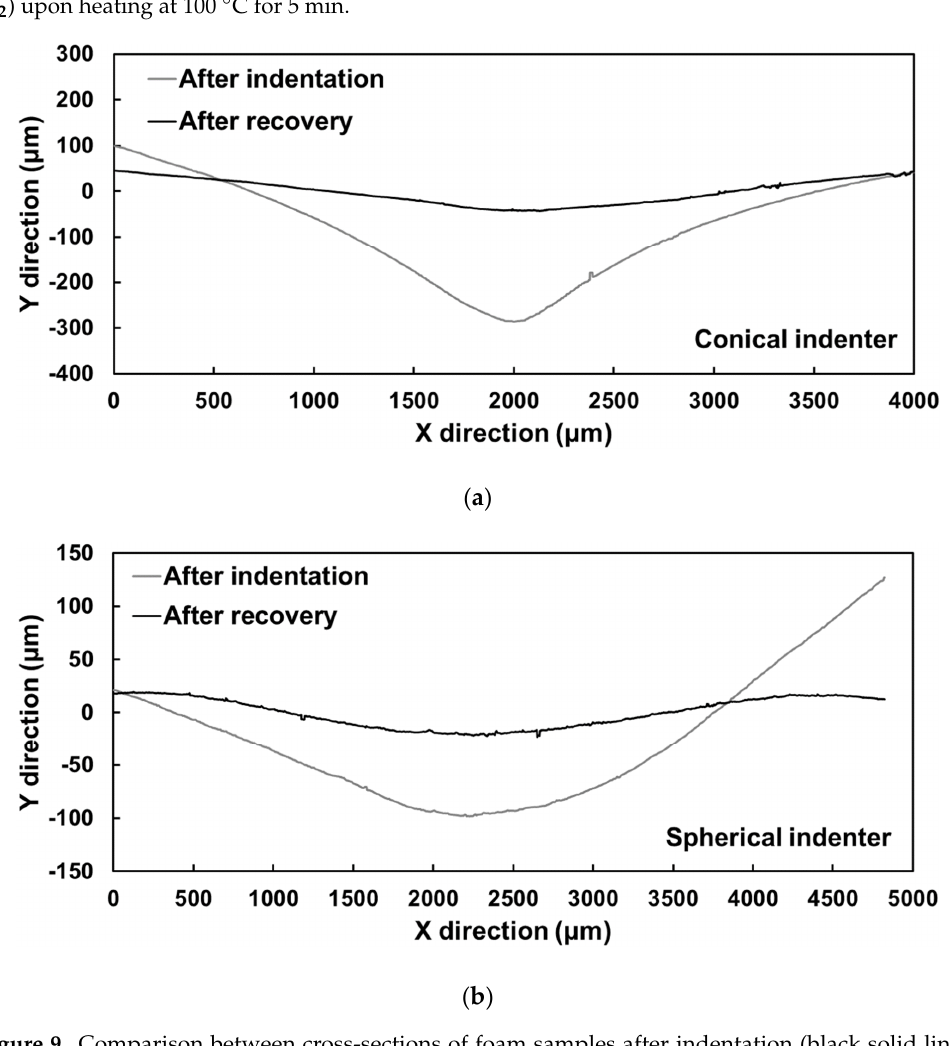
Figure 9. Comparison between cross-sections of foam samples after indentation (black solid lines) and recovery (grey solid lines). ( a ) Sample indented with conical indenter; ( b ) sample indented with spherical indenter.